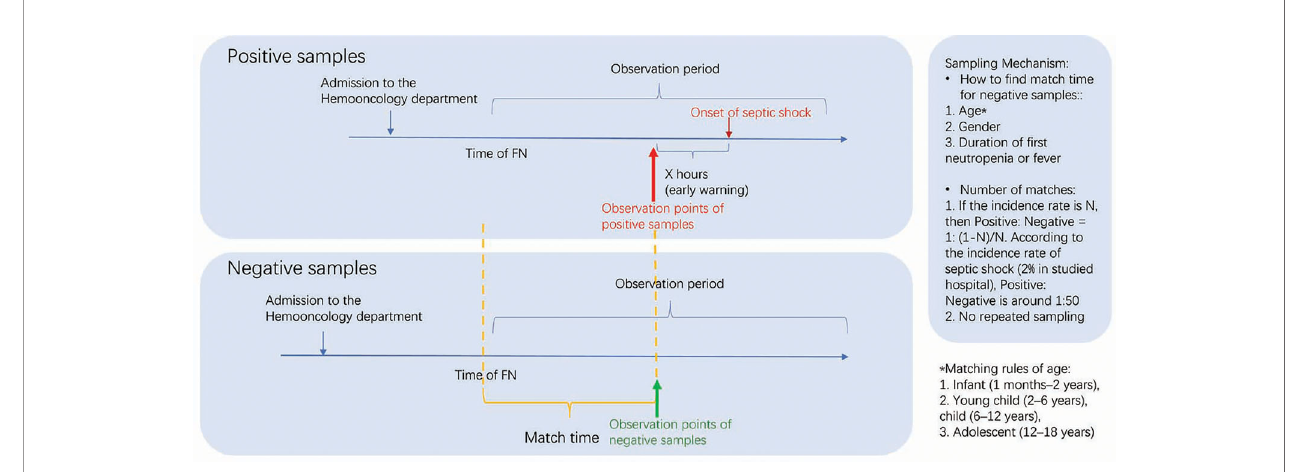
FIGURE 1 | Diagram of episode sampling mode in the